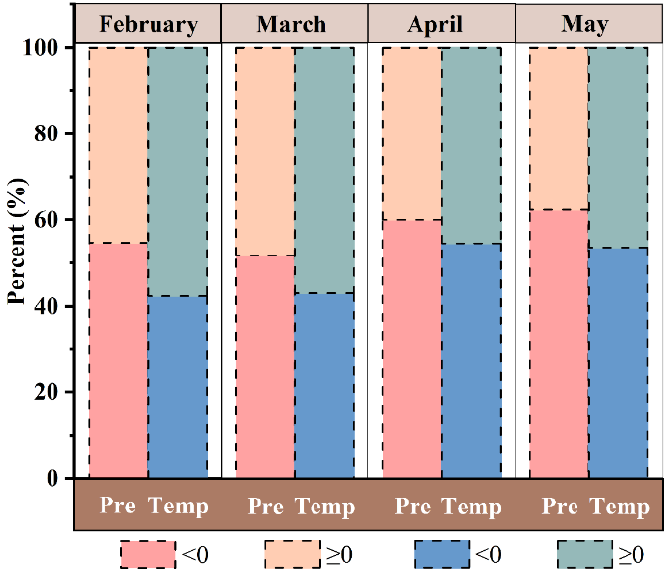
Figure 7. Graded ratios of the positive/negative correlation coefficients of the SOS and precipita- tion/temperature.